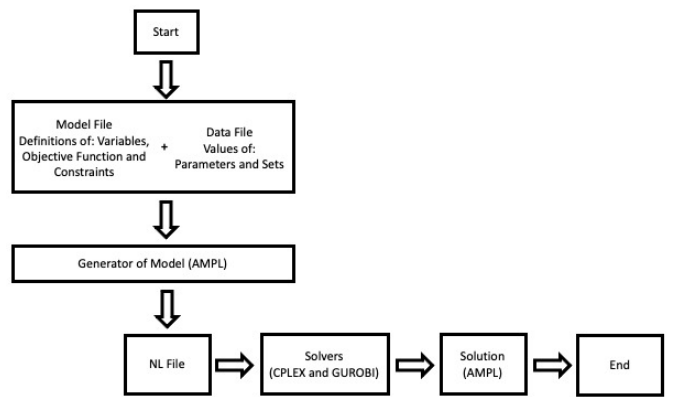
Figure 1. Block chart of the proposed solution method. Source: By the